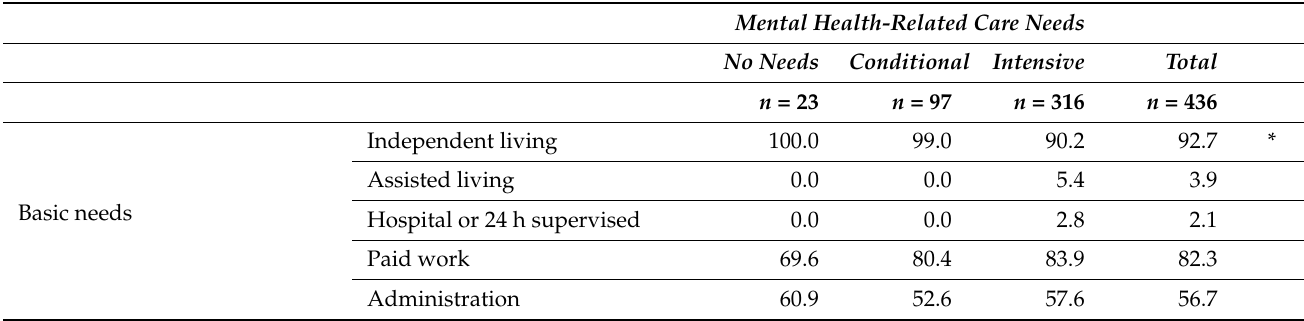
Table 2. Focus of vital basic and health needs in subgroups and total